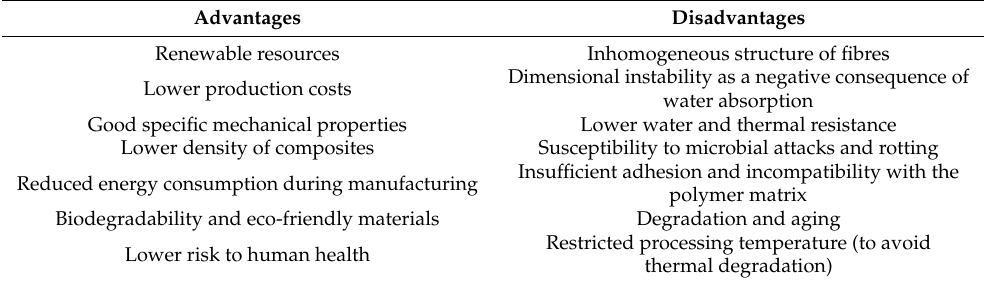
Table 4. The advantages and the disadvantages of fully green composites over conventional petrochemical-based composites [46] with permission from Faculty of Design and Technology of furniture and interior, 2017.